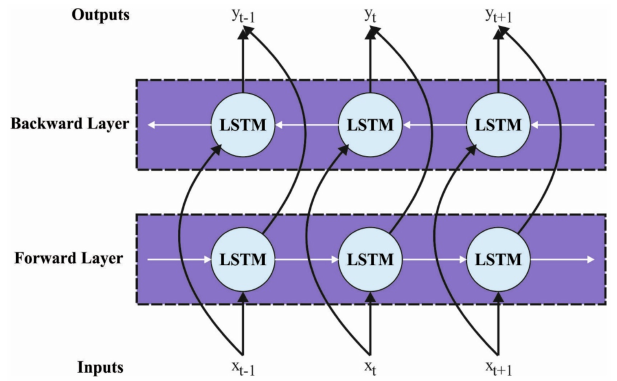
Figure 2. Structure of BiLSTM